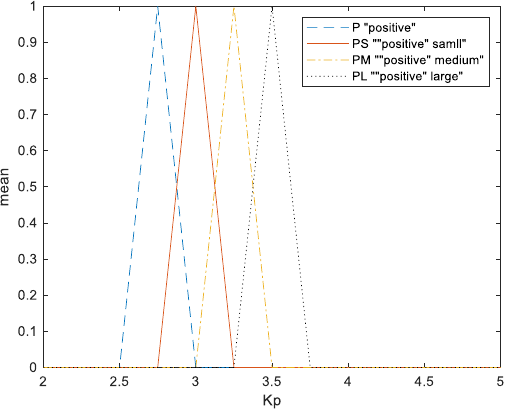
Figure 16. Membership functions of parameter Kp.